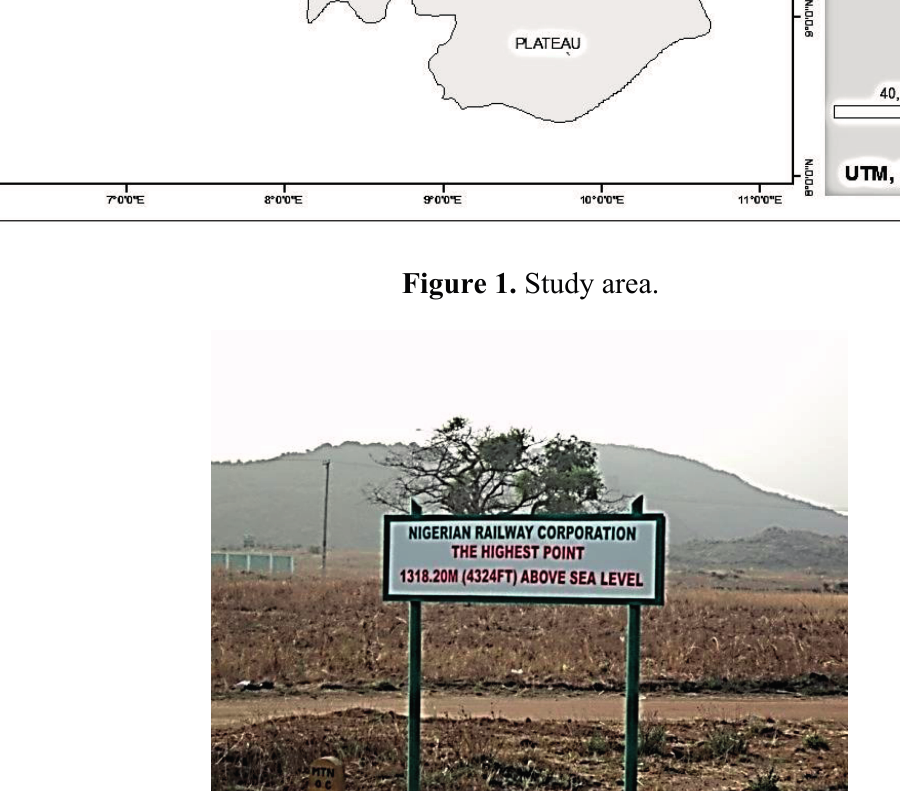
Figure 2. A view of the study area (Kuru, near Jos on the Jos